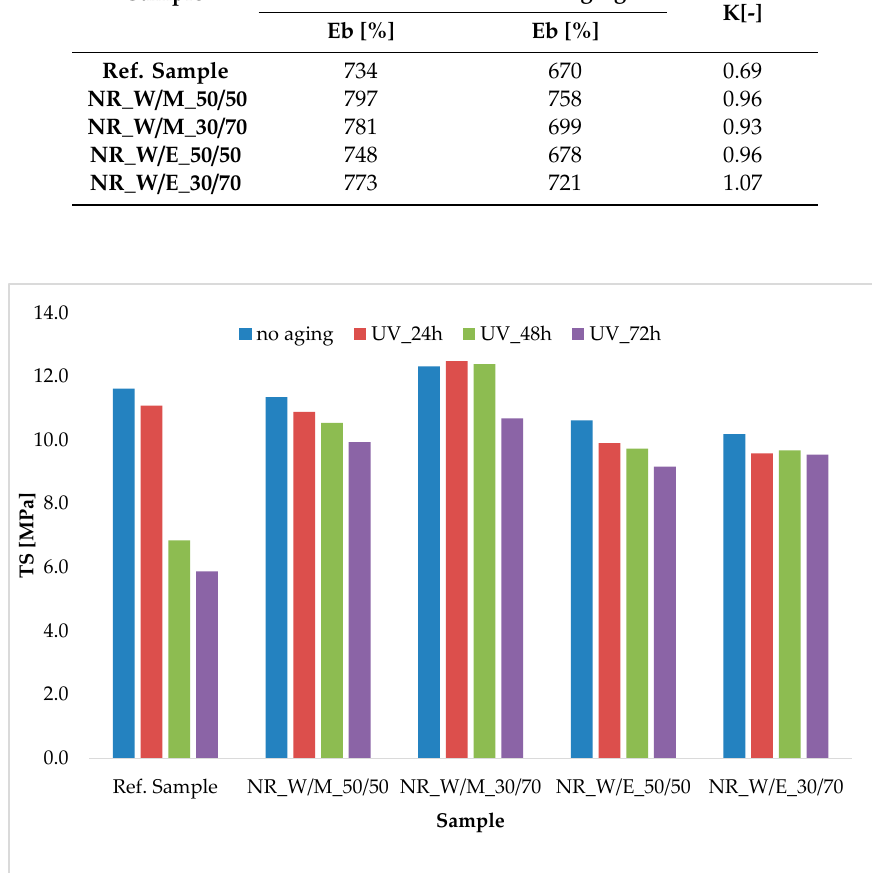
Figure 6. Tensile strength of vulcanizates before and after simulated UV aging process. Table 7. Elongation at break of vulcanizates before and after simulated UV aging process and aging factor (K).